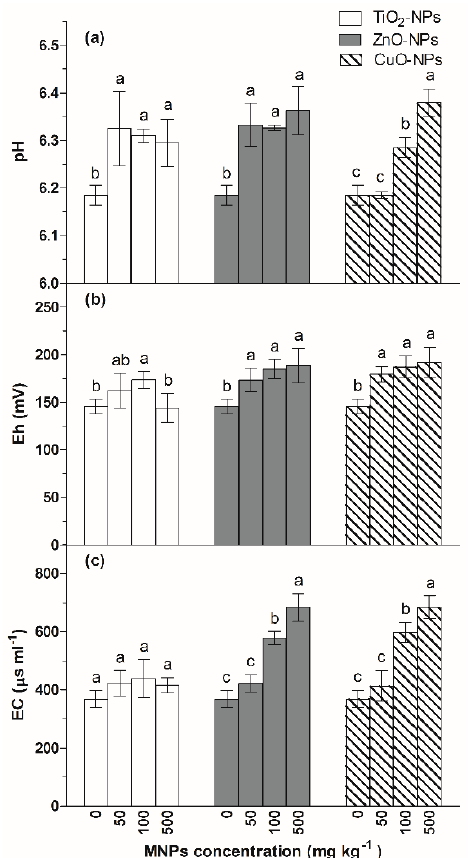
Figure 1. Changes in the values of soil pH ( a ), redox potential (Eh) ( b ) and electric conductivity (EC) ( c ) of the soil exposed to different MNPs. Different letters above each column indicate significant difference ( p < 0.05) between various treatments in same group.